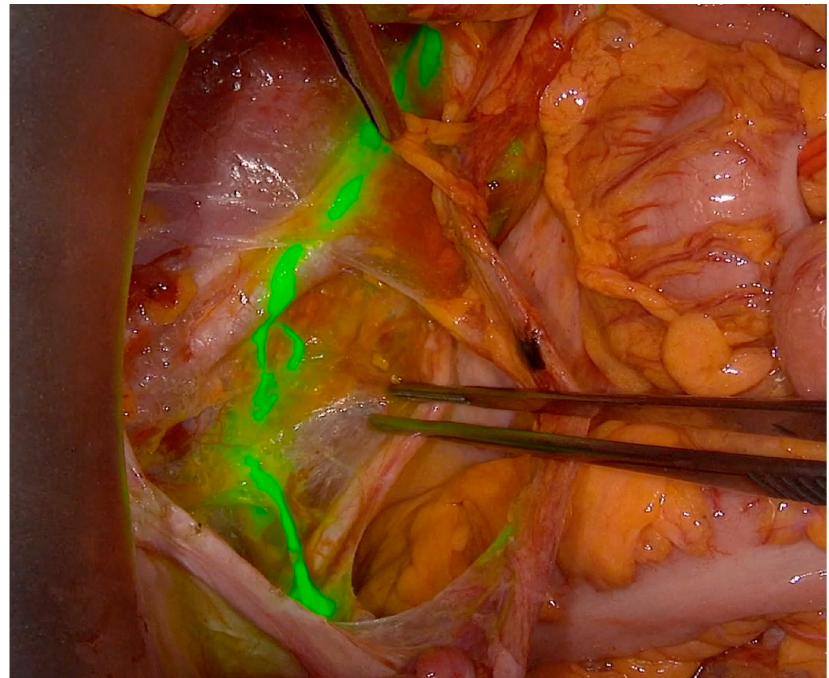
Figure 2. Posterior paracervical (supra-ureteral) pathway of lymphatic spread explored with ICG and SPY-Portable Handheld Imager (SPY-PHI) in open surgery.